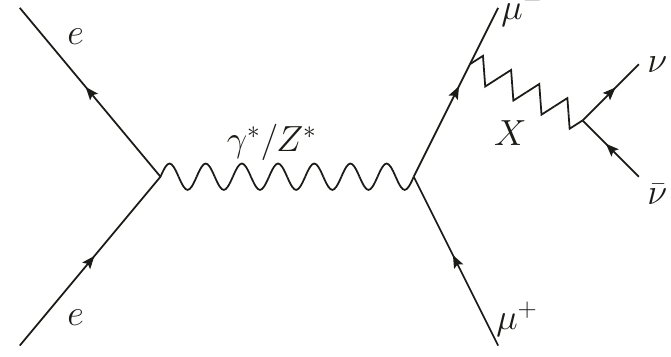
Figure 3 . The X gauge boson production in e + e (cid:0)